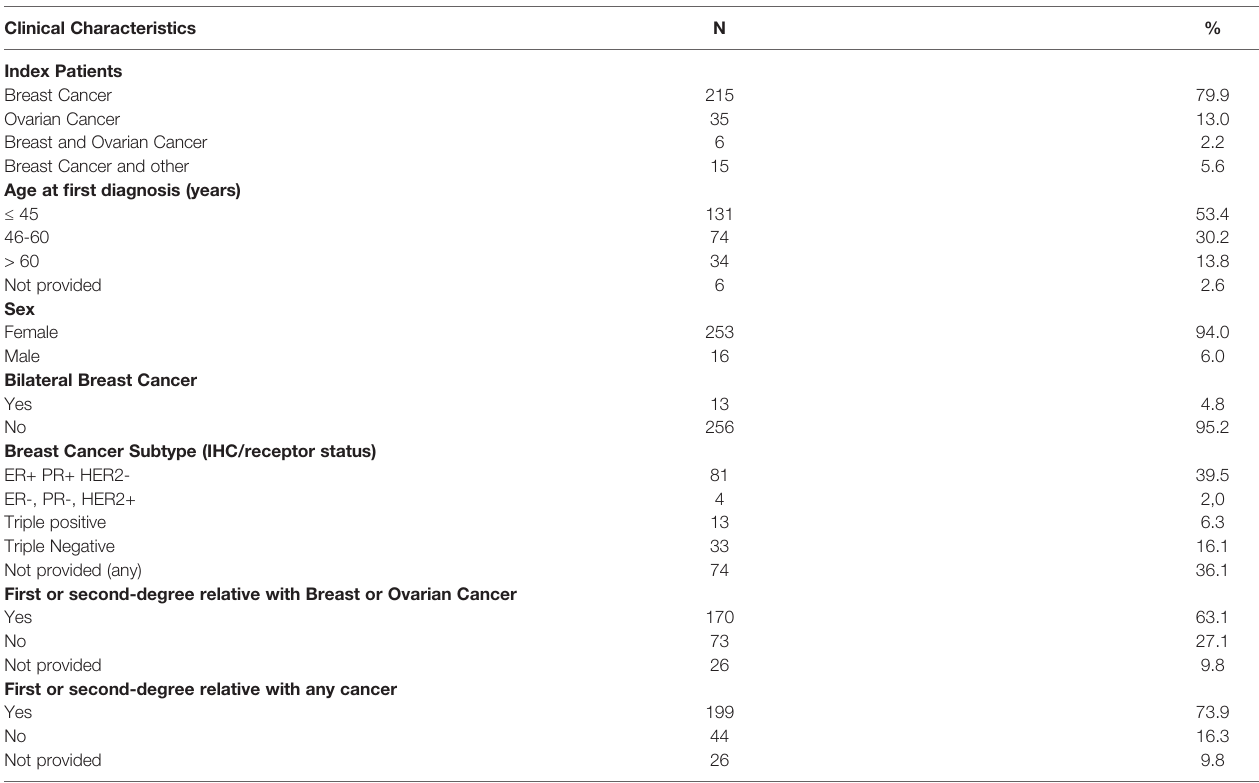
TABLE 1 | Clinical characteristics of patients with breast or ovarian cancer in the CHANCE